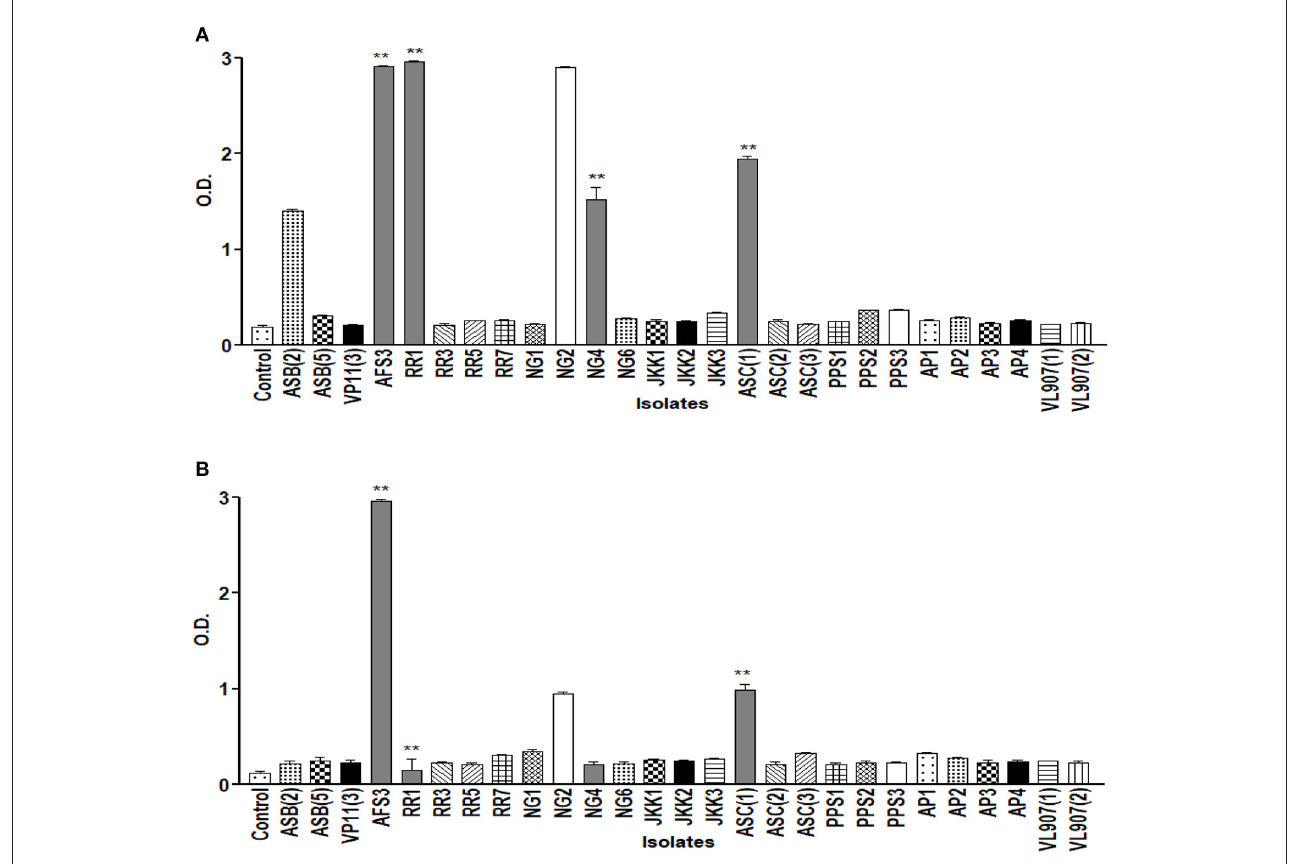
FIGURE3 Graph showing growth curve at different pH (A) 4.5; (B) 9.5 of all 27 isolates. ** = p value <